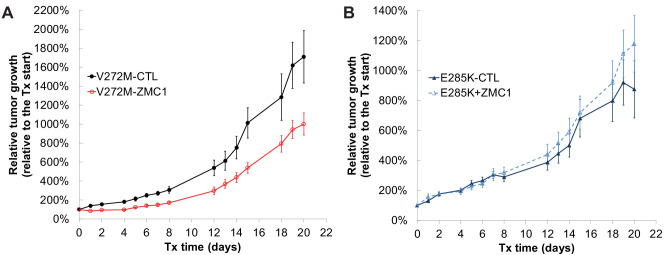
In vivo efficacy of ZMC1 in stability-class mutants V272M (A) and E285K (B).Mice bearing human xenograft tumors were treated with ZMC1 (5 mg/pk daily, IP) or DMSO vehicle. See Methods for treatment and allocation details. Treatment and control groups were n = 14 and n = 12, respectively, for both V272M and E285K xenografts. All sites exhibited tumor growth and none were excluded from analysis.